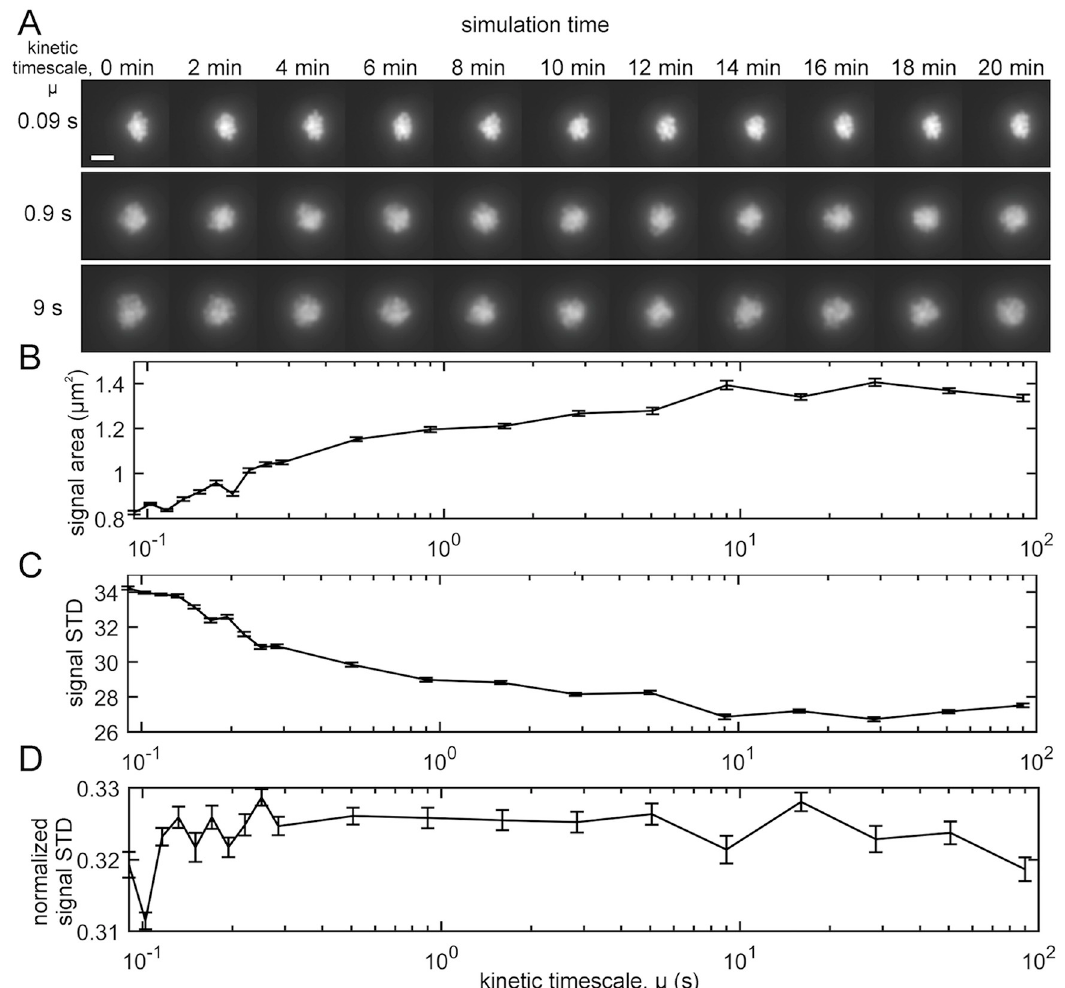
Fig 3. Simulated microscope images for polymer bead-spring model with transient crosslinking and varying kinetic timescale μ . Varying μ alters the area and variance of the intensity for the nucleolar signal, which models the affect of the fob1 Δ and hmo1 Δ mutations. (A) Timelapse montage of simulated microscope images for μ 2 {0.09, 0.9, 9} (seconds). Scale bar is μ m. (B) Area of nucleolus signal ( μm 2 ) as a function of μ 2 [10 − 1 , 10 2 ]. Areas were calculated by measuring the area of the binary mask generated by applying Otsu’s threshold to each image. (C) Standard deviation of the (non-normalized) nucleolus signal versus μ . (D) Standard deviation of the normalized nucleolus signals versus μ ; these we normalized identically to the normalization of the experimental microscope images. In panels (B)-(D), error bars indicate standard errors observed using 22 time points for each value of μ .